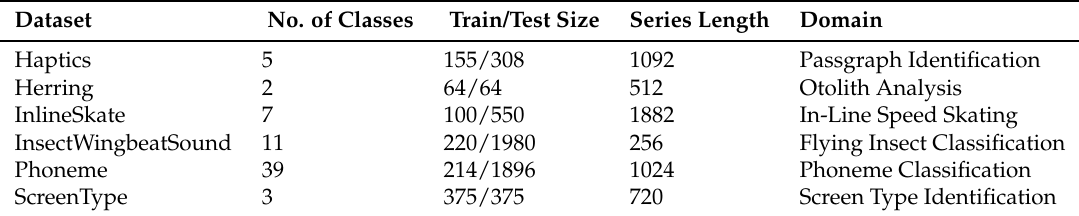
Table 2. Datasets